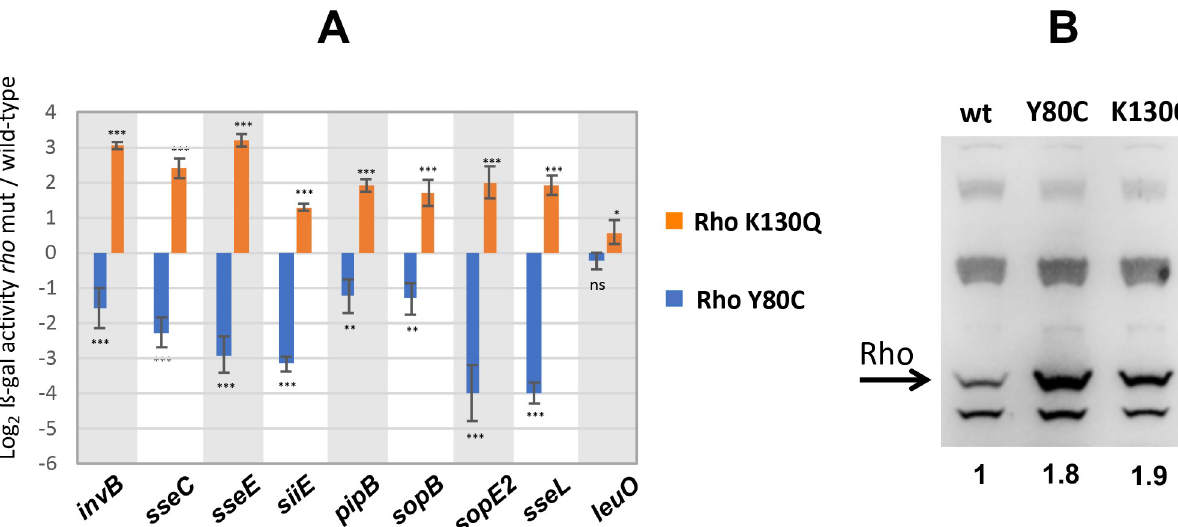
Fig 3. Effects of Rho mutations on the expression of lacZ fusions to NusG-regulated genes (A) and on Rho protein accumulation (B). (A) Effects are expressed as log 2 of the ratio between the value of ß-galactosidase activity measured in the mutant versus that measured in wild-type (at least two independent assays, each with two biological replicates). Statistical significance was calculated using unpaired two-tailed Student’s T test ( ��� , P < 0.001; �� , P < 0.01; � , P < 0.05; ns, P > 0.05). Standard deviations of ratios were calculated by the formula STDV ratio = ß-gal mut /ß-gal wt x SQRT [(STDV mut /ß-gal mut ) 2 + (STDV wt /ßgal wt ) 2 ]. (B) Western blot analysis of strains carrying wild-type and mutant rho alleles using anti-Rho polyclonal antibodies. Values below the blot represent the fold change in the intensity of the Rho band (quantified with ImageJ) normalized to the non-specific signal immediately below the Rho band.